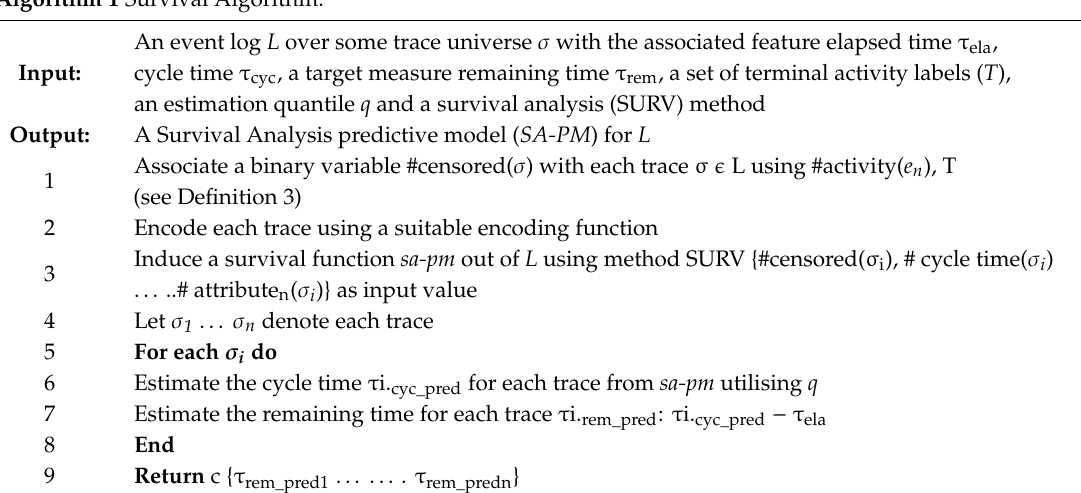
Algorithm 1 details the survival analysis predictive modelling algorithm. Algorithm 1 Survival